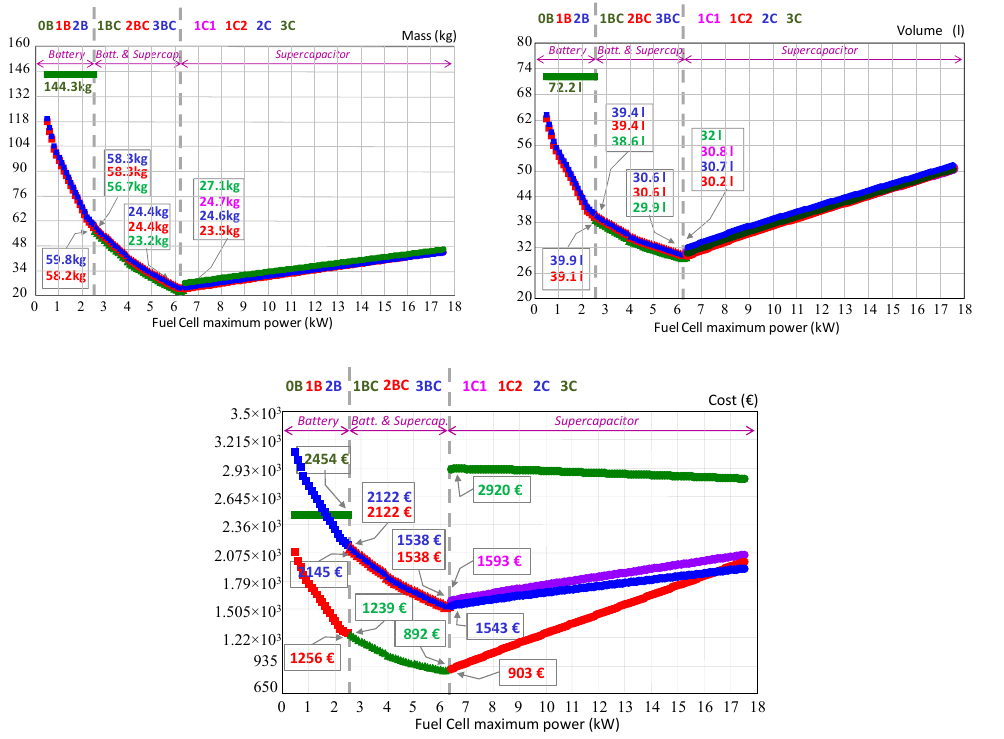
Figure 22. Architectures mass (kg), volume (l) and cost ( € ), depending on the fuel cell maximum power.